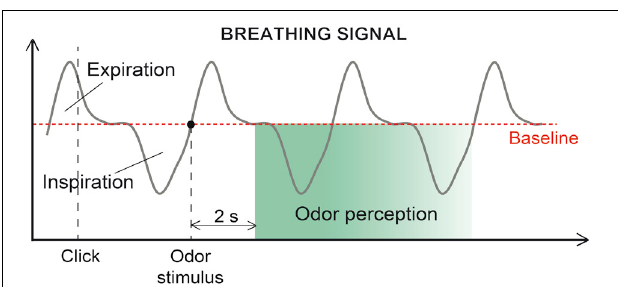
FIGURE 2 | Breathing signal. Course of a typical breathing signal depicting successive expirations and inspirations. The odor was sent at the beginning of the participant’s expiration to ensure odor perception at the beginning of the next inspiration, which occurred approximately 2s later (in green, period of odor perception, fading with